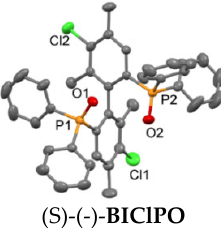
380 Figure 4. The CD spectra of (S) ‐ ( ‐ ) ‐ BICLPO (black) and (R) ‐ MeO ‐ BIPhEPO (red) recorded in CH 3 CN. Other than the cases described in Achiwa’s work [55,56], our attempts to separate BIMOPO ( 9c ) enantiomers by fractional crystallization with addition of DBTA did not lead to satisfactory results. This was the case with further efforts to use chiral acids such as 2,3 ‐ di(phenylaminocarbonyl) tartaric acid [57], monodimethylamide DBTA, naproxen, mandelic acid or similar tested in a wide range of organic solvents. Surprisingly, resolu ‐ tion of racemic BIMAPO ( 11b ), which contains amino groups at 5,5 ′‐ positions, also failed. Our further attempts focused on the application of chiral C,N ‐ palladacycle complex which binds the bisphophine ligands. For this purpose, the palladium complexes 14 and 15 were used, which have been synthesized according to the literature data [58] (Figure 5). Figure 5. Palladium complexes 14 and 15 for the bisphosphines’ resolution.